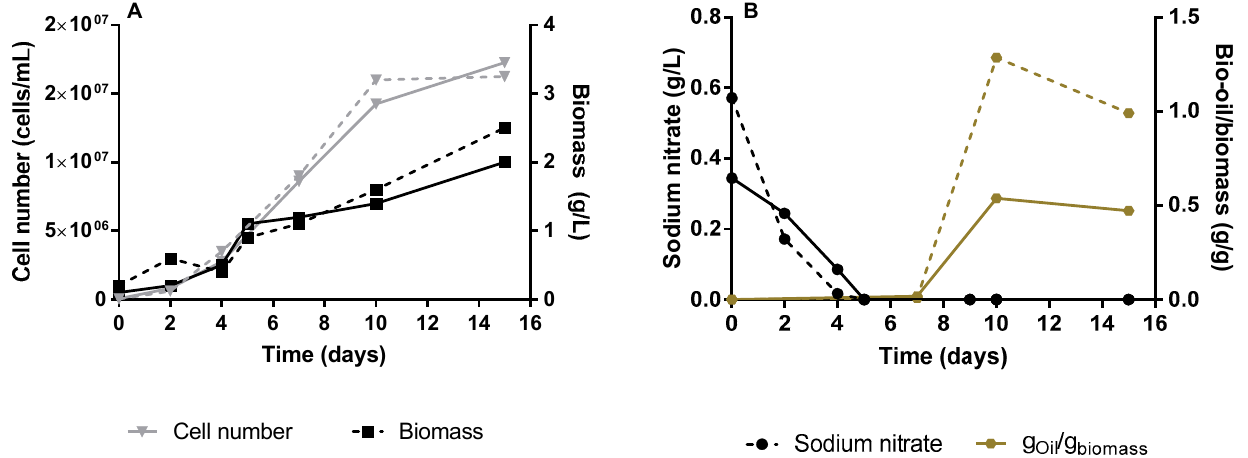
Figure 2. Cultivation of Neocloris oleoabundans #1185 in air-lift bioreactors for 15 days: cell number (inverted triangles) and biomass growth (squares) ( A ); sodium nitrate consumption (circles) and production of bio-oil per gram of biomass ( B ). Dashed and filled lines correspond to biological duplicates.